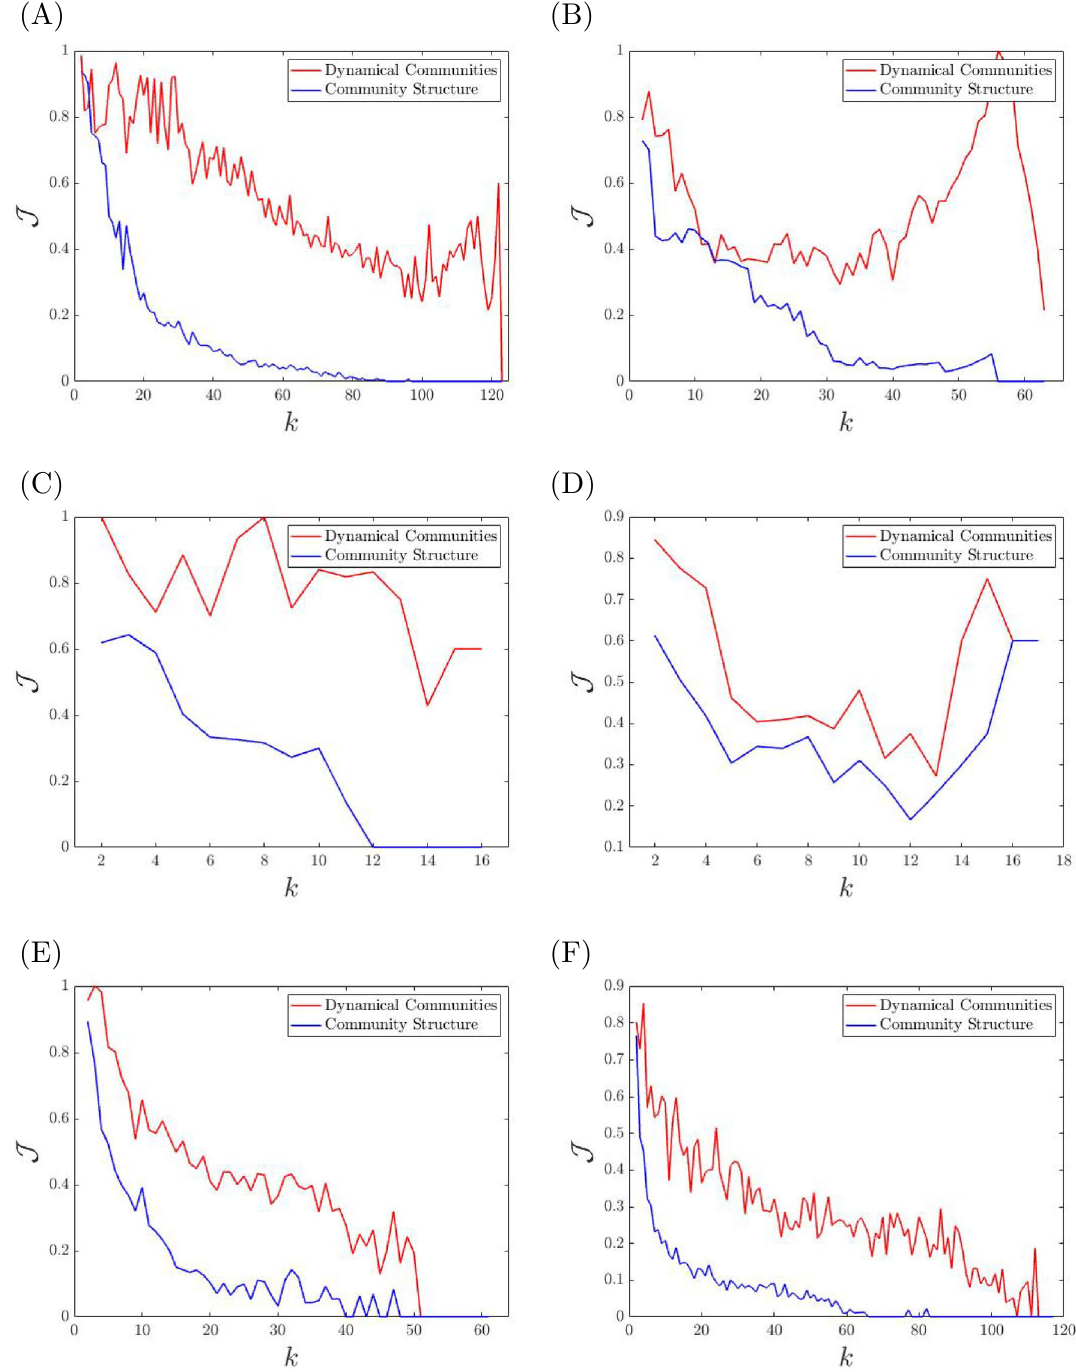
Figure 8. We plot the Jaccard index versus the number of clusters k , for both our dynamical communities (in red) and community structure (in blue). We plot the results for several real world networks, and see a strong advantage of using dynamical communities over community structure. The networks considered here are: ( A ) Journal and magazine 38 ( B ) Train bomber 39 ( C ) Kangaroo ( D ) Southern Women 40 ( E ) Stock market ( F ) Power